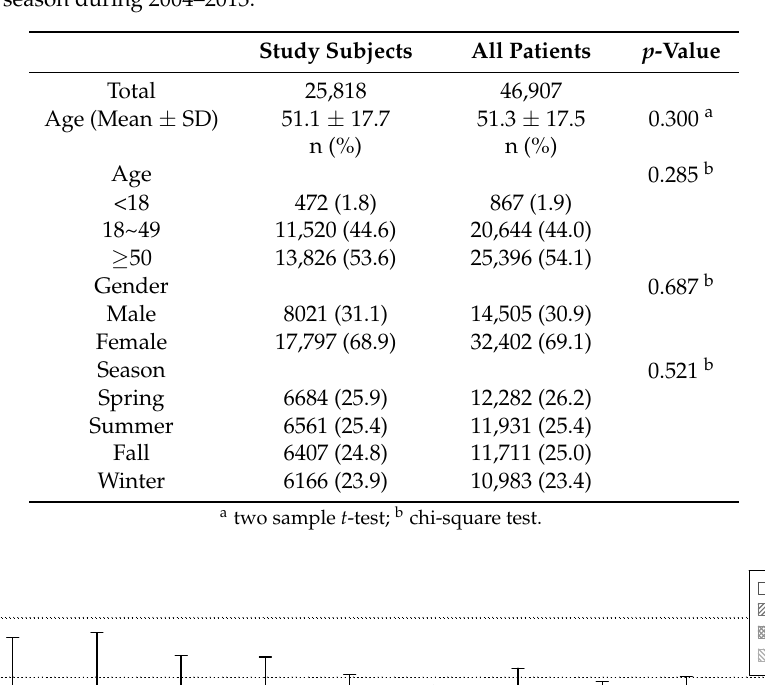
Table 1. Data for study subjects and all patients at the first occurrence of dry eye disease (DED) by age, gender and season during 2004–2013.